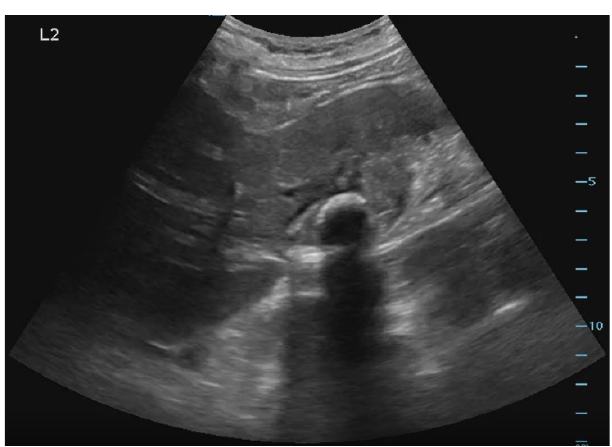
Key words: Ultrasound; Diagnostic; Intestinal Fistula; Colonic Neoplasms; Adenocarcinoma; Incidental Findings. (Source: MeSH-